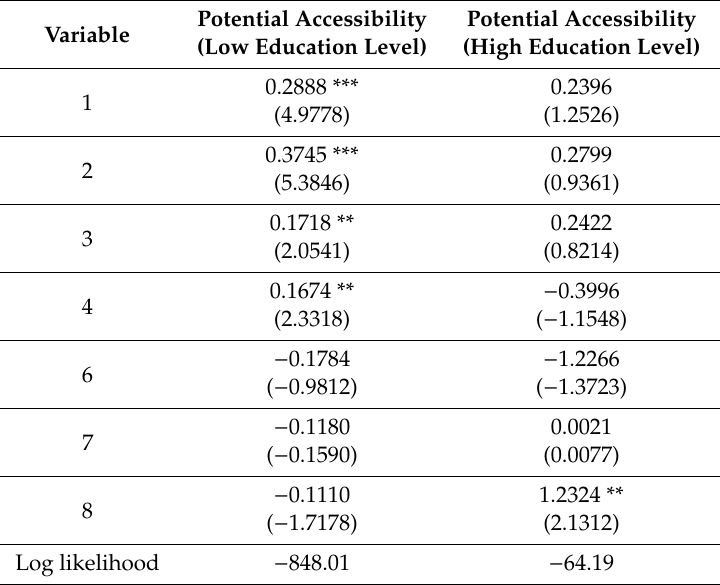
Table 5. The impact of education level on potential